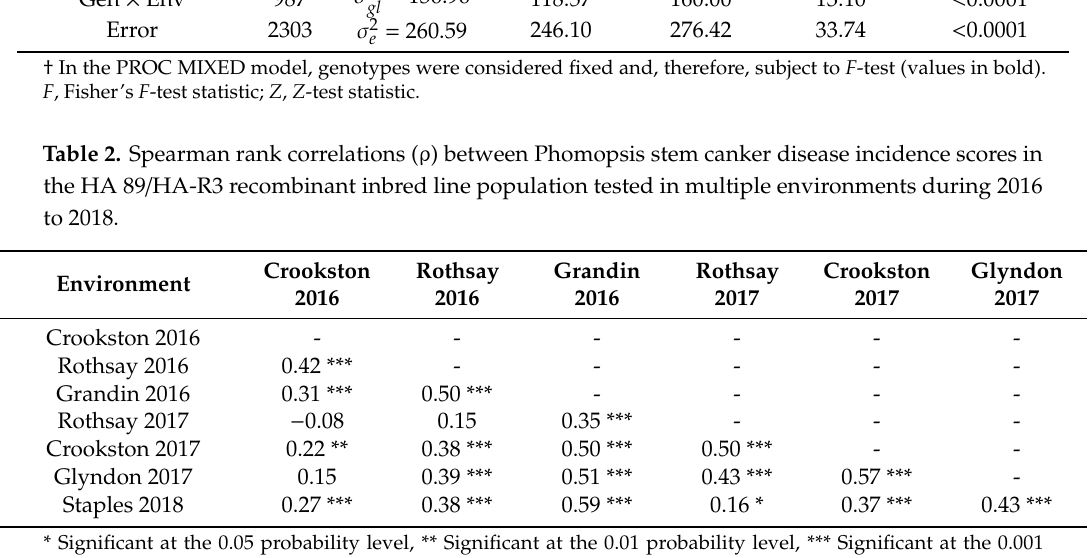
Table 1. Combined analysis of variance (ANOVA) for Phomopsis stem canker disease incidence scores among HA 89 / HA-R3 recombinant inbred lines tested in multiple environments during 2016 to 2018. Confidence Limit (0.05) F / Z Value p -Value > Variance Component df † F / Z Estimate Lower Upper Genotype (Gen) 165 - - - Environment (Env)